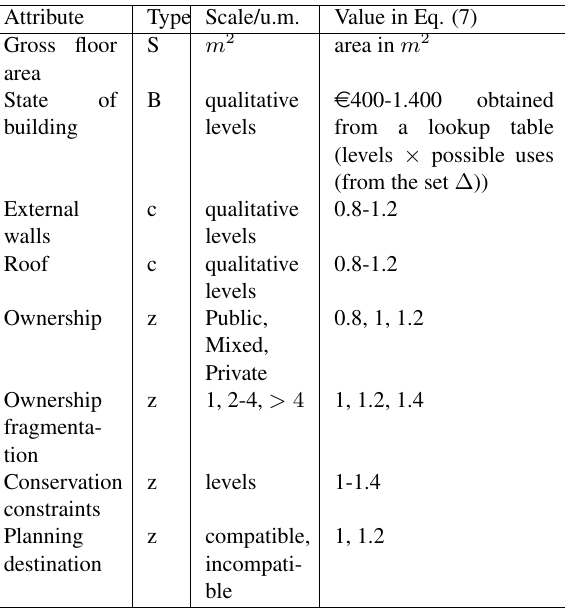
Table 1. Building attributes for the estimation of the transformation cost of